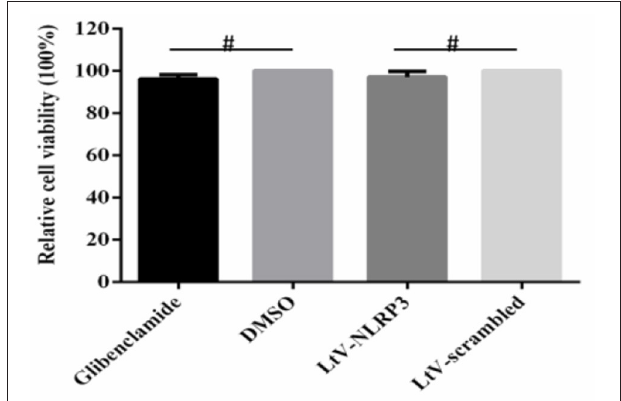
FIGURE 8 | Effect of shRNA interference on cell viability . The viability of PBMCs treated with glibenclamide, DMSO, LtV-NLRP3, and LtV-scrambled shRNA was analyzed using the EthD-III/calcein AM staining assay (mean ± SD; n = 3; NSP > 0.05). # P > 0.05. P -values were calculated using an One-way ANOVA test.